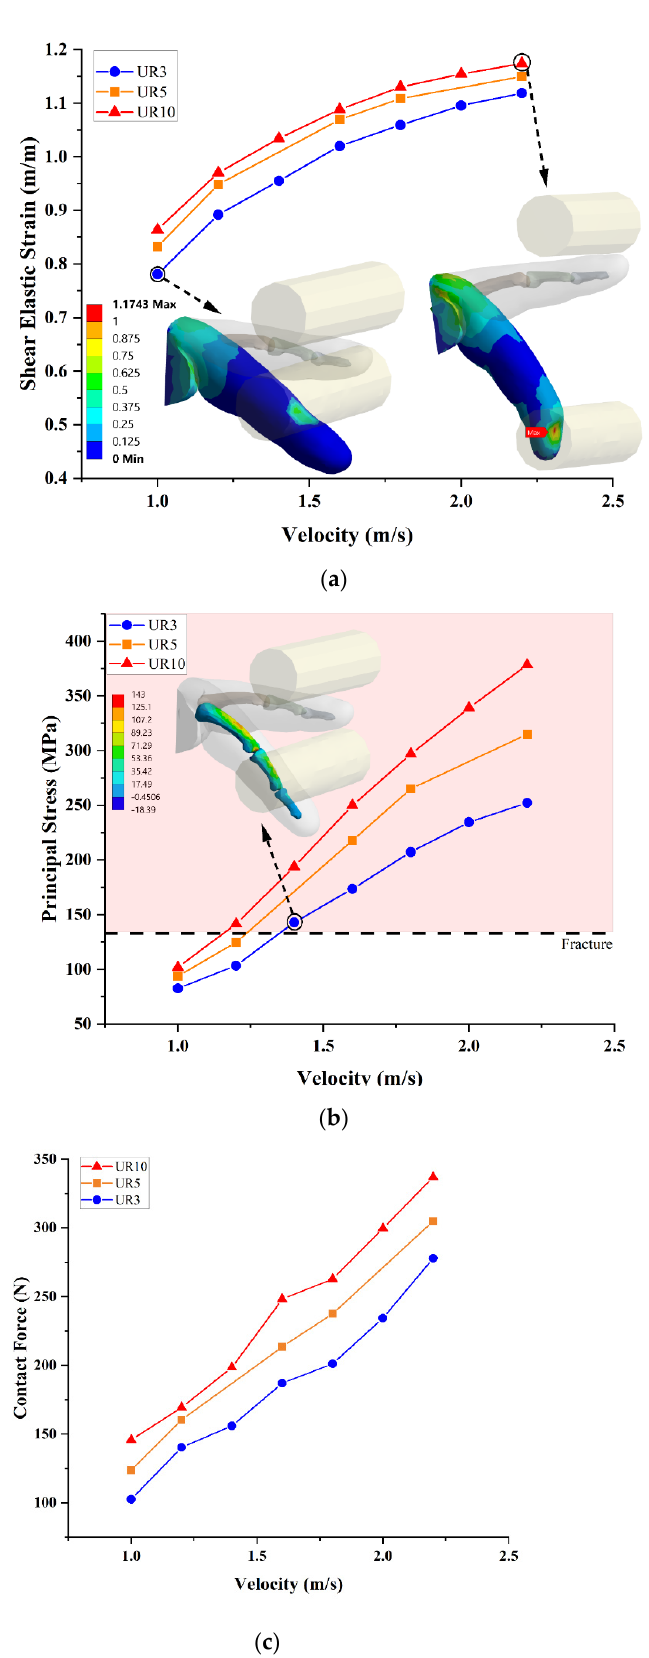
Figure 10. Flexion as a function of end effector velocity and effective mass, with contour results at the points shown: ( a ) Elastic Strain, ( b ) Principal Stress, and ( c ) Contact Force.